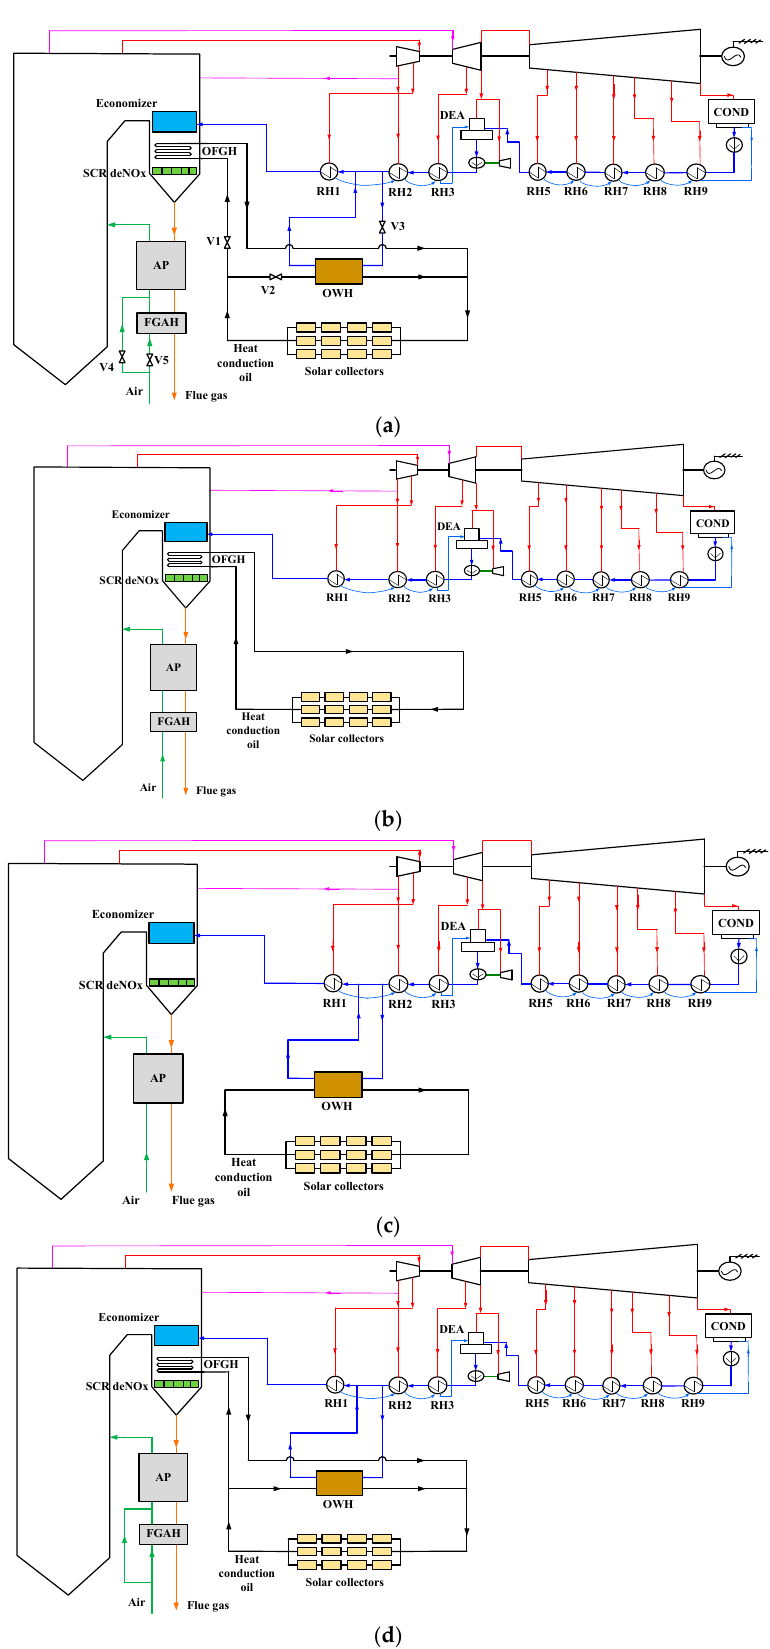
Figure 4. Schematic of the proposed SAPG. ( a ) Overall schematic; ( b ) Low load; ( c ) high load; ( d ) medium load.